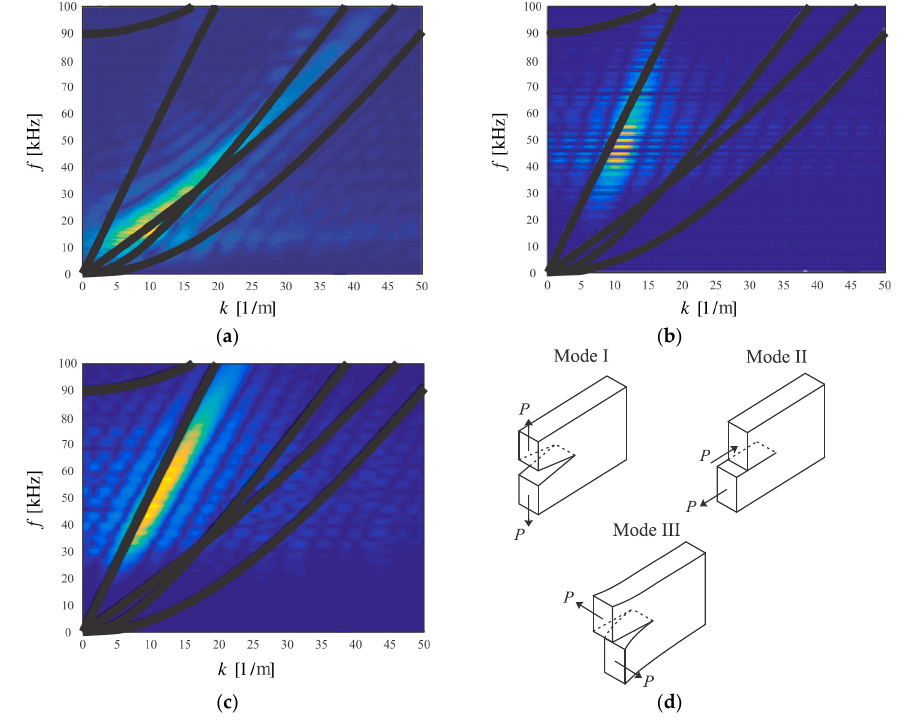
Figure 20. Results in the Frequency vs. wave-number domain. ( a ) in Mode I, ( b ) in Mode II, ( c ) in Mode III. ( d ) The spatial distribution of the three modes of fissure crack propagation, AE emitted from the pre-fissure solicited.